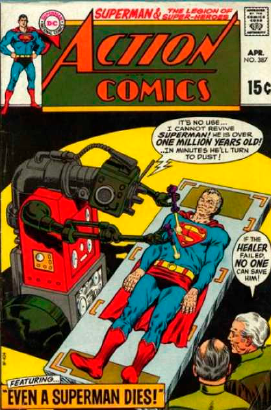
Figure 8. Action Comics #387, “Even A Superman Dies!” (April 1970) [10] .